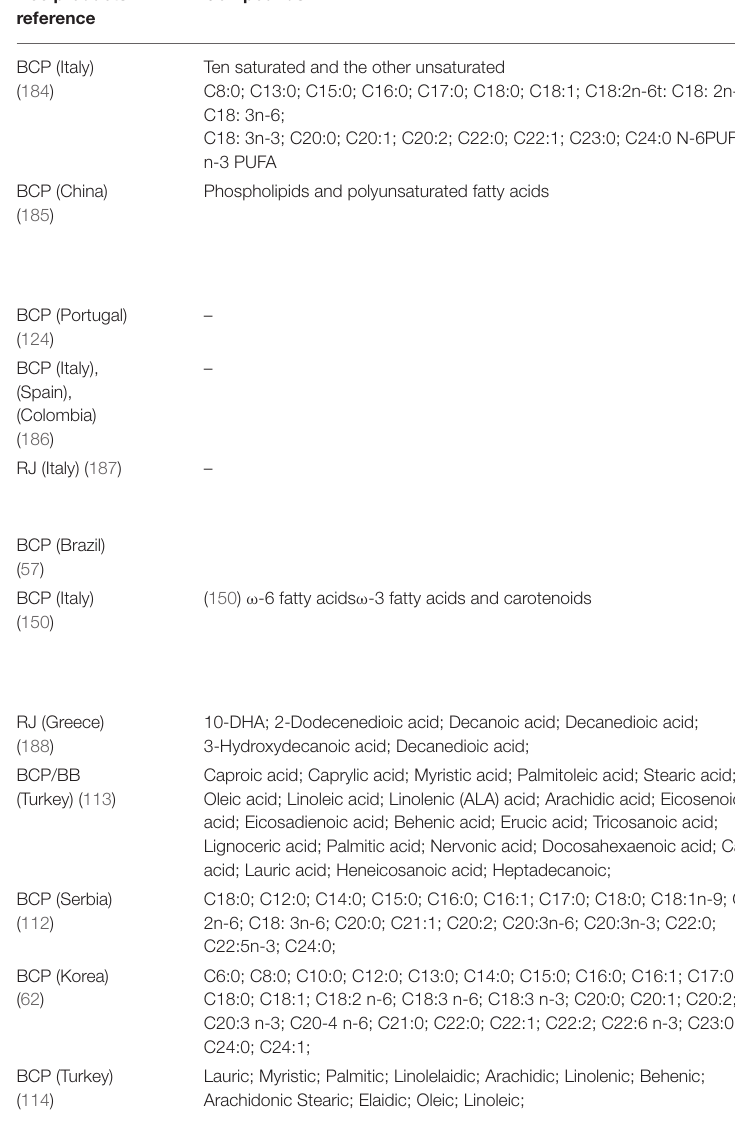
TABLE 3 | Lipid extraction, separation purification, and identification of the fatty acids from the bee products (2017–2021). Bee products